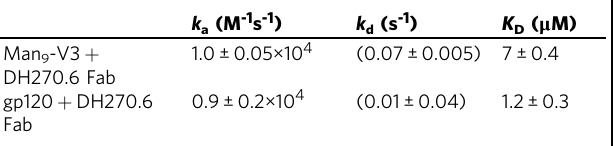
CDRH3 loop accepts a hydrogen bond from the D325 backbone Table 1 Rate constants and equilibrium dissociation amide (Fig. 2c). The R327 guanidinium group also hydrogen constants for binding of DH270.6 Fab with Man 9 -V3 and bonds with S103 H . Mutating D325 to Arg leads to a complete loss with gp120 of detectable binding to HIV-1 Env, con fi rming the importance of this residue for antibody recognition 12 . The Env R327A mutant -1 s -1 ) k has only a slightly lower af fi nity for DH270.6 than its wild-type a (M counterpart (Fig. 4a), while the S103G mutation weakens the Env interaction twofold (Fig. 4b, Table 2). Thus, for the DH270 1.2 ± 0.3 lineage, contacts with the GDIR peptide backbone (by R57 H and D107 H ) and with the D325 side chain (by N52 H ) are essential sites of interaction with the conserved anchor region of Env V3; Association rate constants ( k a ) and equilibrium dissociation constants ( K D ) were determined the antibody – R327 interaction is a less critical, secondary contact from duplicate BLI measurements at fi ve concentrations (Supplementary Fig. 4). Dissociation rate constants were calculated as the products of k a and K D . Errors are point. In addition to interactions through R57 H , DH270.6 forms an extended network of polar contacts with the 324 GDIR 327 motif, dependent bnAbs typically have a long CDR loop that can contact further distinguishing antibodies in this lineage from other both glycan and protein residues. DH270 lineage members have V3-glycan bnAbs. In particular, N52 in the CDRH2 loop donates shorter CDRs than other bnAbs of the same class 12 , but it is a hydrogen bond to the D325 carboxylate, fi xed in its side-chain nonetheless their longest CDR, the CDRH3, that contacts the V3 conformation by a salt bridge with R327, and D107 in the peptide. In our Man 9 -V3:DH270.6 structure, the N332 glycan and